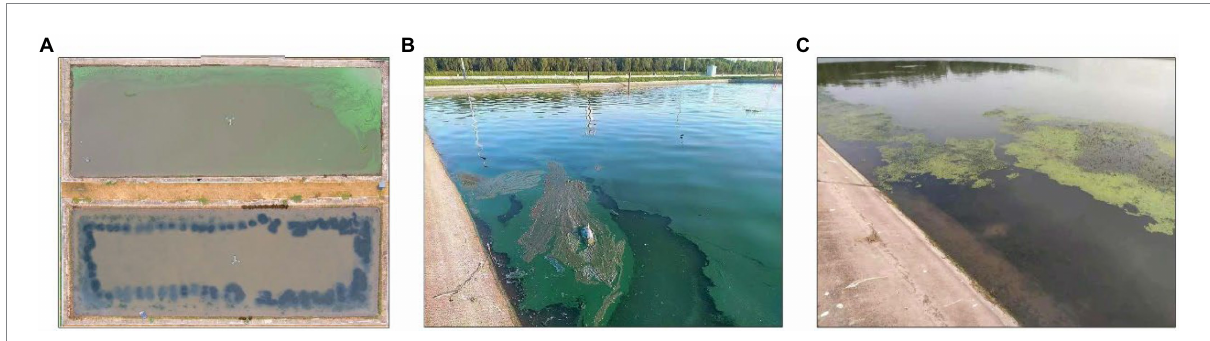
FIGURE 2 Examples of ponds during aquaculture. (A) Top views of an M group pond (at the upper part of the picture) and an EM group pond (lower part of the picture). (B) Close-up view of an M group pond. (C) Close-up view of an EM group